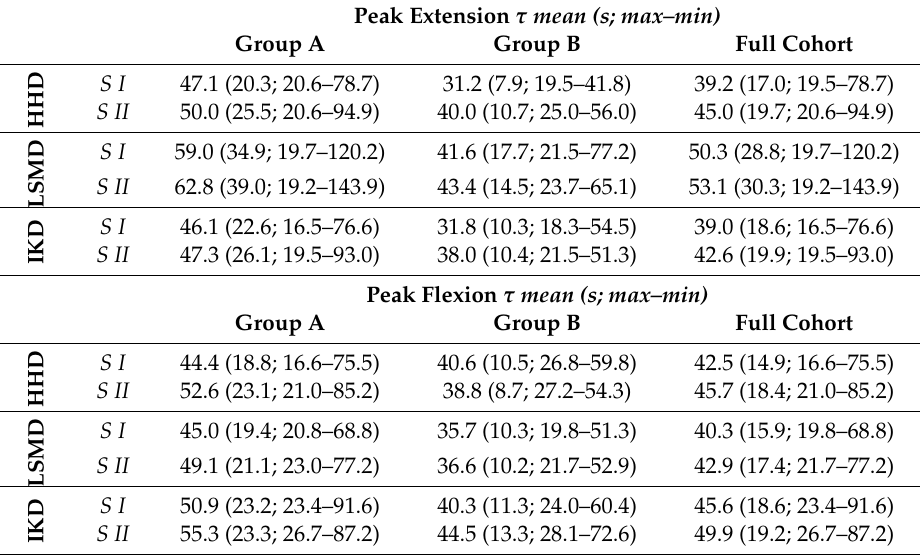
Table 3. Peak torque characteristics of each participant group and full